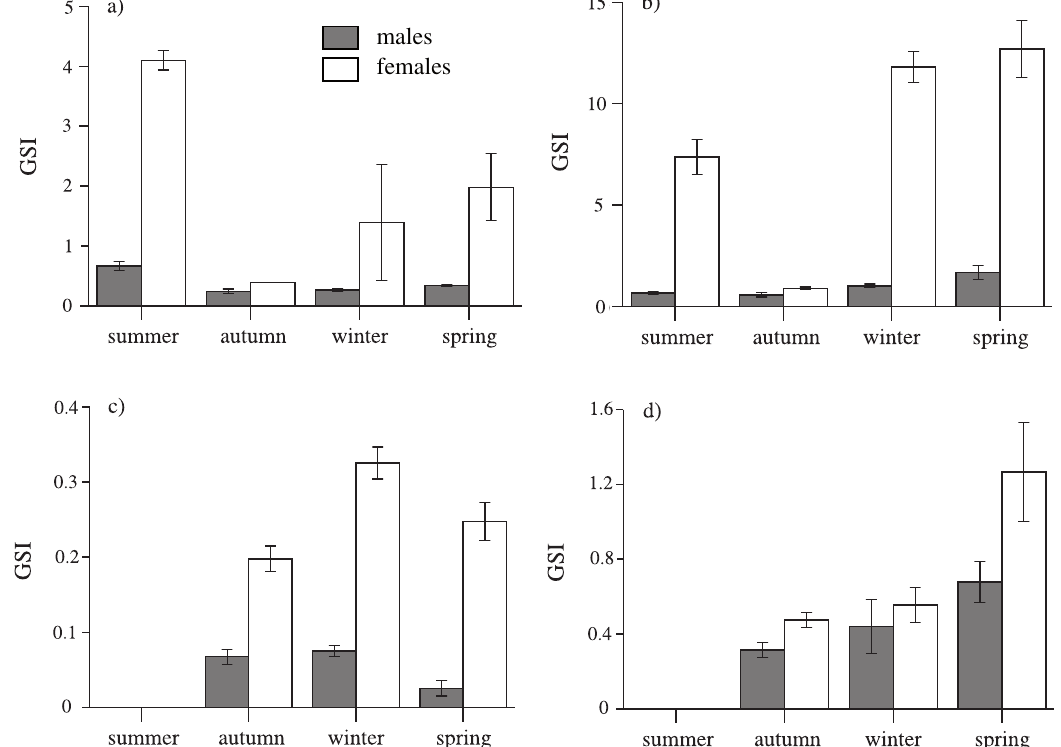
Fig . 3. − Seasonal mean ± S.E. gonadosomatic index of males and females of the studied species: (a) Salaria pavo (males = 213, females = 137), (b) Pomatoschistus marmoratus (males = 116, females = 125), (c) Gobius cobitis (males = 59, females = 80), (d) Gobius niger (males = 84, females =